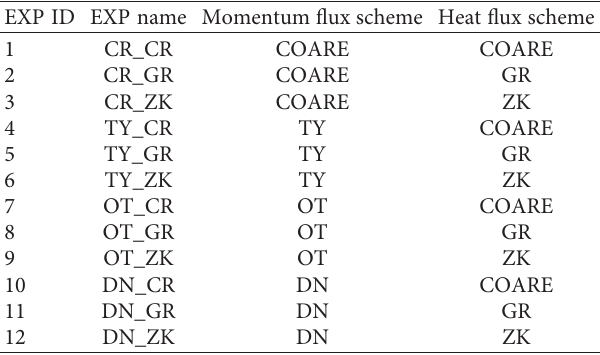
Table 2: Parameterization schemes of momentum and heat flux in 12 experiments.